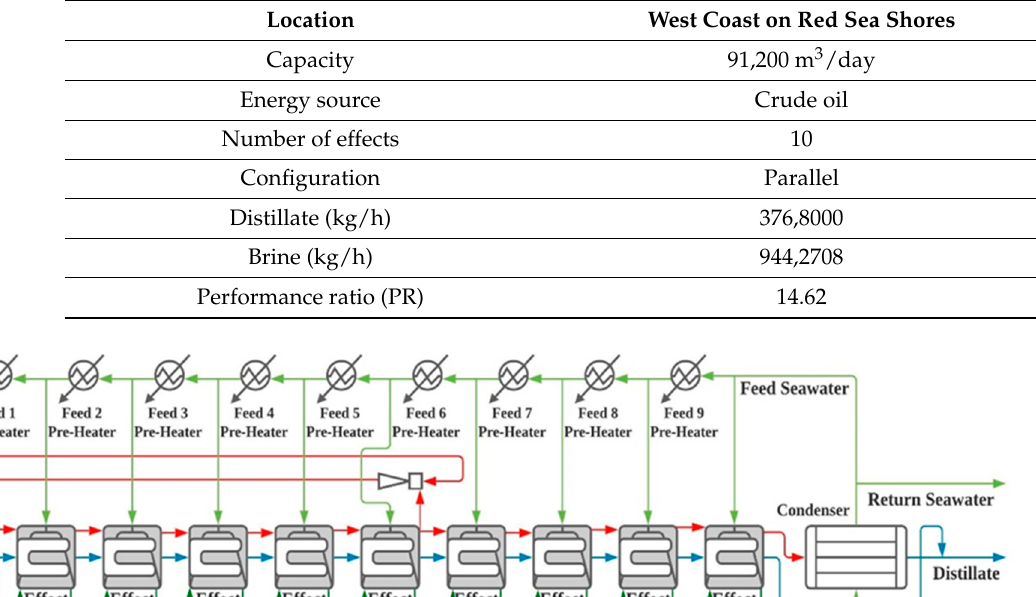
Table 1. Existing MED-TVC Desalination Plant’s Specific Information.